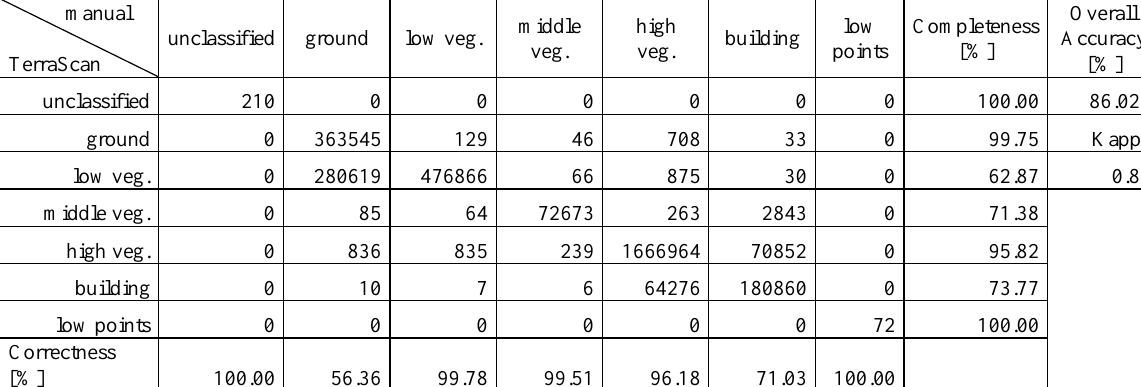
Table 2 Confusion matrix and accuracy estimates for the TerraScan classification manual